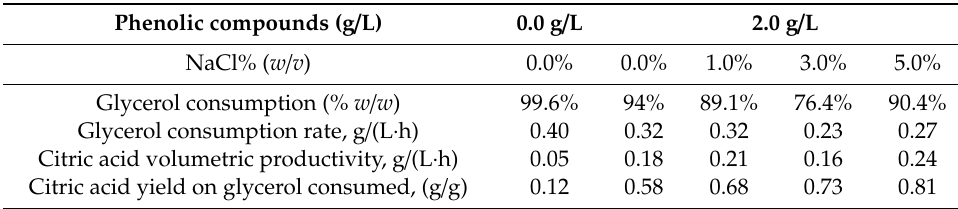
Table 2. Glycerol consumption (%), glycerol consumption rates, citric acid production rates, and specific citric acid production rates during fermentations of glycerol (70.0 g / L) with and without phenolic compounds (2 g / L) and with increased concentrations of NaCl (0.0%, 1.0%, 3.0% and 5.0% w / v ).